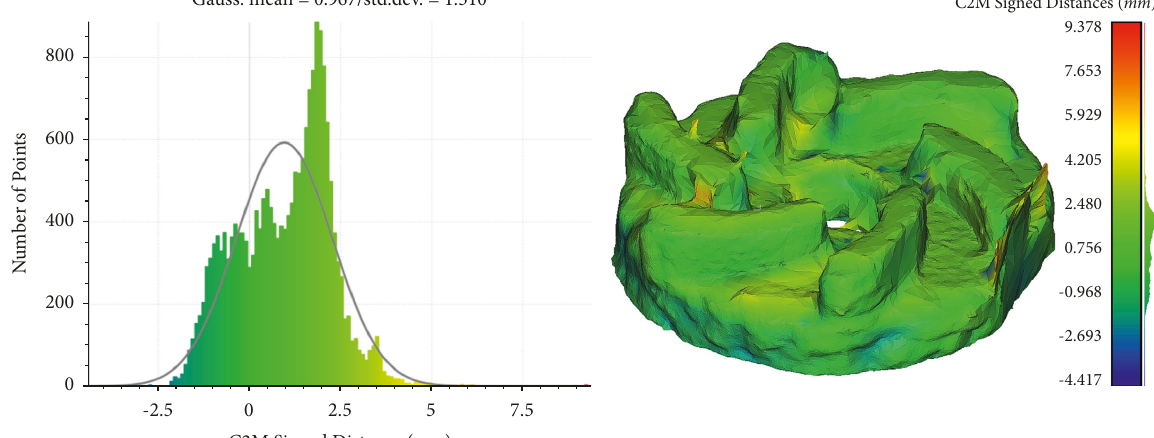
Figure 32: Cloud-to-mesh distance of near-net-shaped CAD model and scanned model of component realized through reusable substrate method.